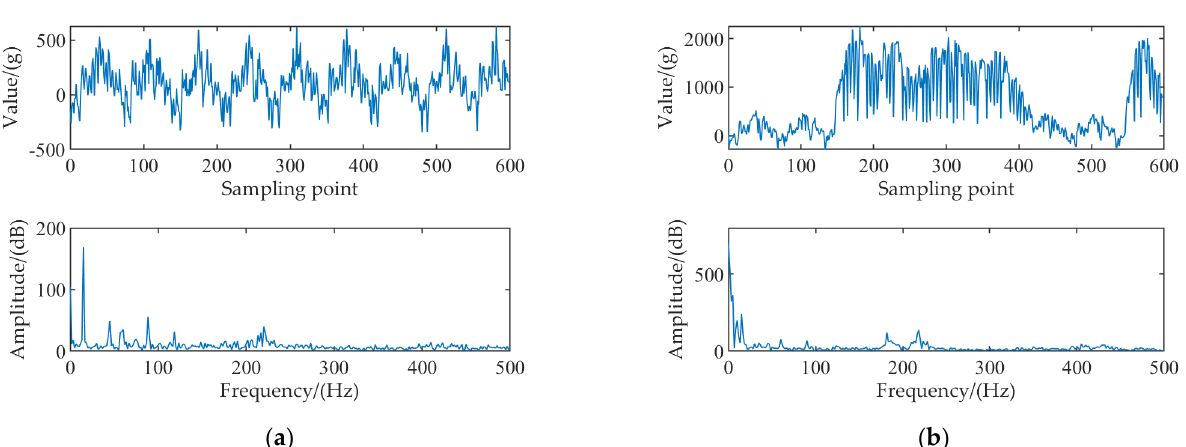
Figure 3. Spectrum analysis of the non − load and loaded signals of the electronic belt scale: ( a ) Non − load signal; ( b ) Loaded signal.